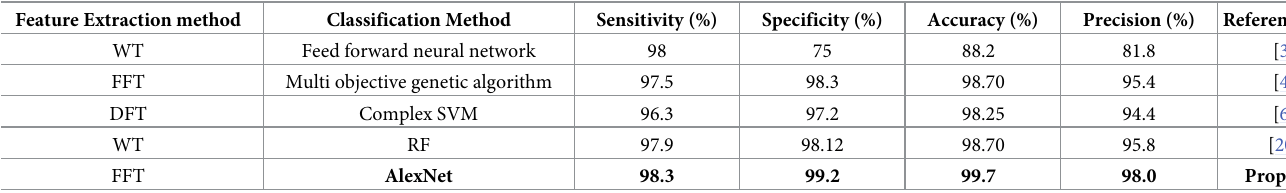
Table 2. Comparative analysis of proposed works.